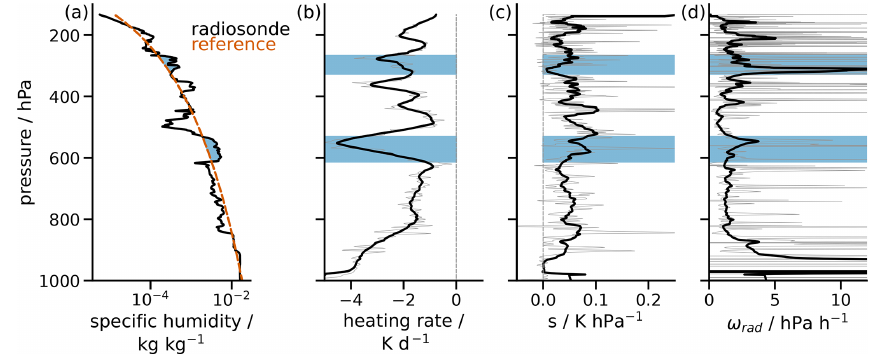
Figure 3. GRUAN sounding from 15 February 2012 at 12:00UTC of (a) H 2 O volume mixing ratio (VMR), (b) longwave heating rate, (c) static stability and (d) radiatively driven vertical velocity. The dashed red line in panel (a) is the reference humidity profile against which moisture anomalies are identified, which are highlighted by blue shaded regions. Thin grey lines in panels (b) , (c) and (d) indicate raw data and thick lines 500m moving